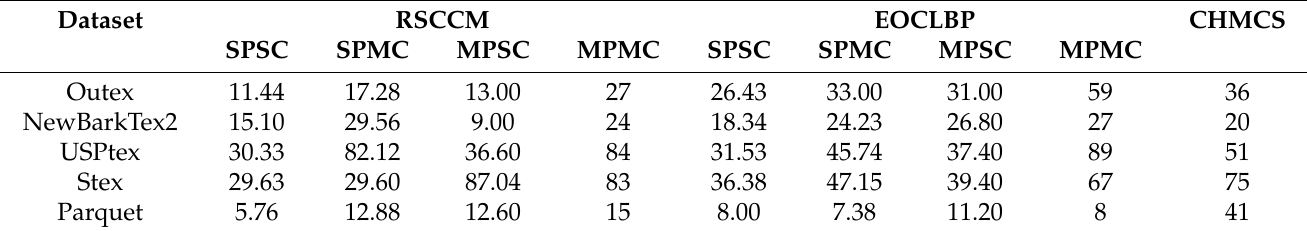
Table 8. Dimensionality of the feature space obtained with the CHMCS descriptor compared to other approaches for each